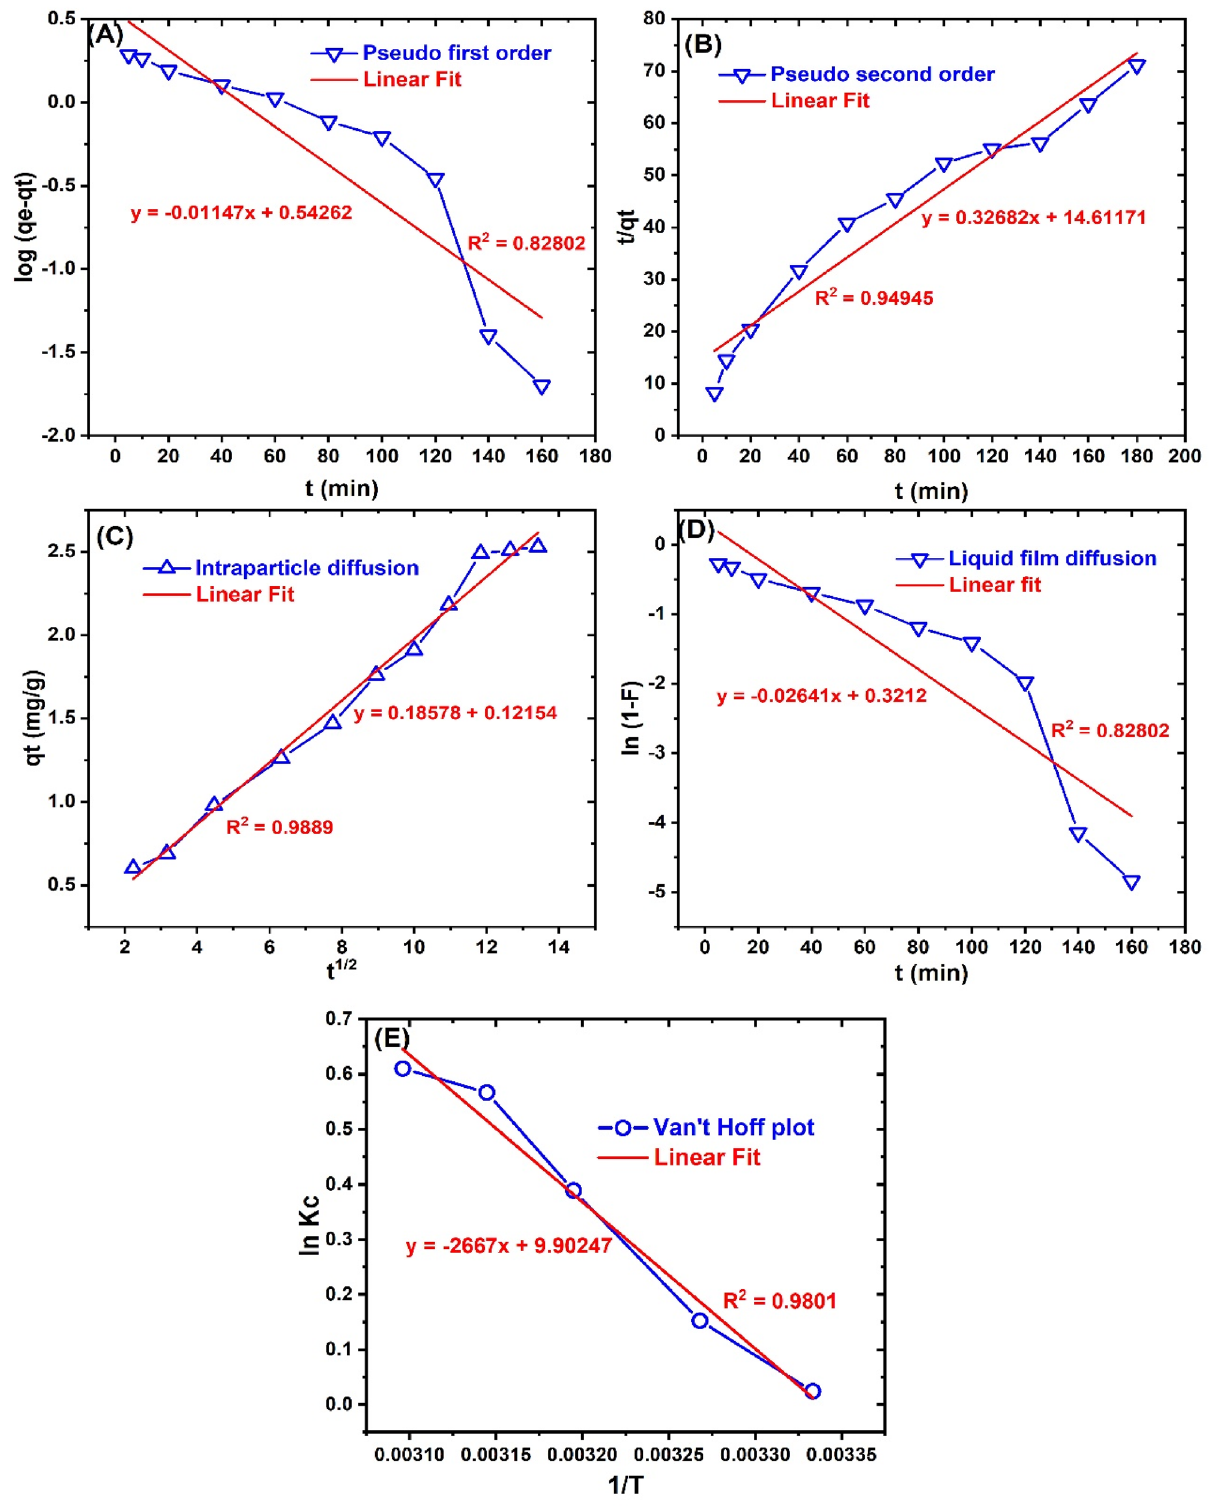
Figure 5. The ( A ) Pseudo-first-order, ( B ) Pseudo-second order, ( C ) Intraparticle diffusion, ( D ) liquid film diffusion and ( E ) Van’t Hoff plots for the adsorption of BRP onto